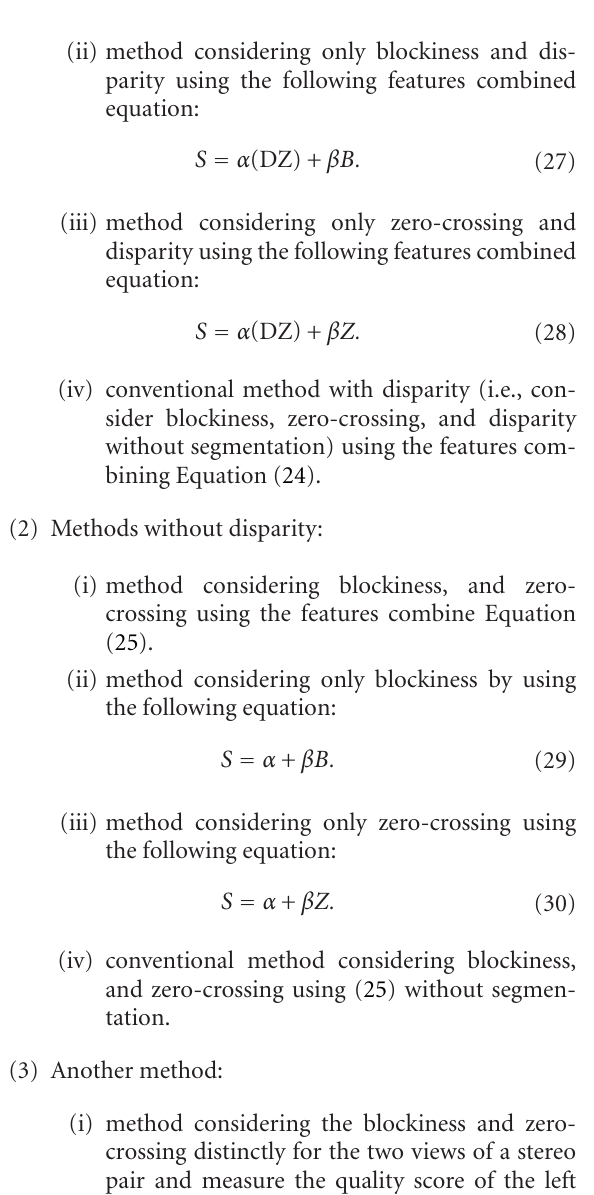
Figure 13: Normalized disparity of the images (I, II, and III) for edge and nonedge areas. (a) Edge areas, (b) nonedge